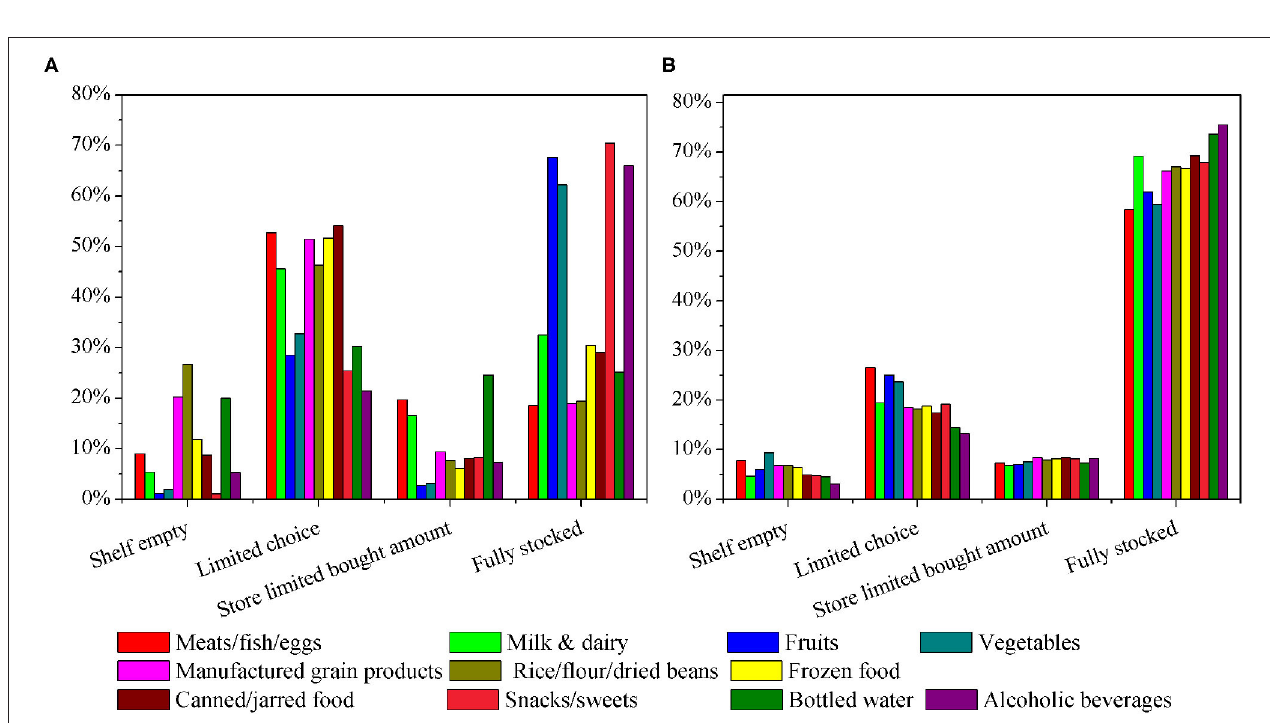
FIGURE 3 | Perception of food security during as compared to before the COVID-19 pandemic. The U.S. cohort exhibited a sharp decrease in confidence in food supply and availability in their area or the nation in general (A) , whereas the Chinese cohort retained their confidence (B) .